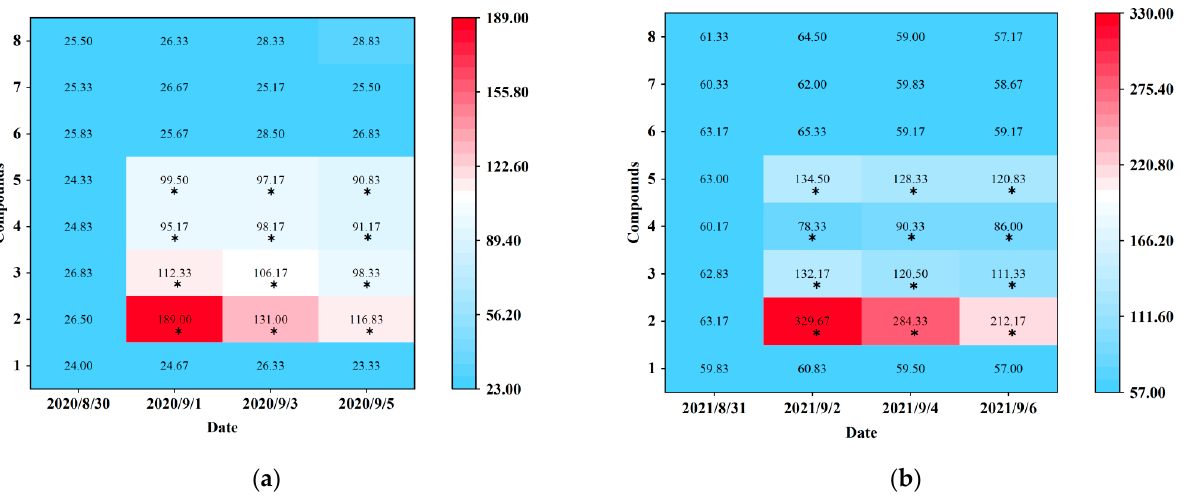
Figure 4. Captures of female Dendrothrips minowai on blue sticky traps baited with control and different compounds. ( a ) Hangzhou in 2020; ( b ) Shaoxing in 2021. Mean captures are shown from six replicates. 1: Hexane (solvent control); 2: P-anisaldehyde; 3: Eugenol; 4: Farnesene; 5: 3-Methyl butanal; 6: (E)- β -ocimene; 7: ( − )- α -pinene; 8: (+)- α -Pinene. “*” denotes a significant difference at p < 0.05 level.